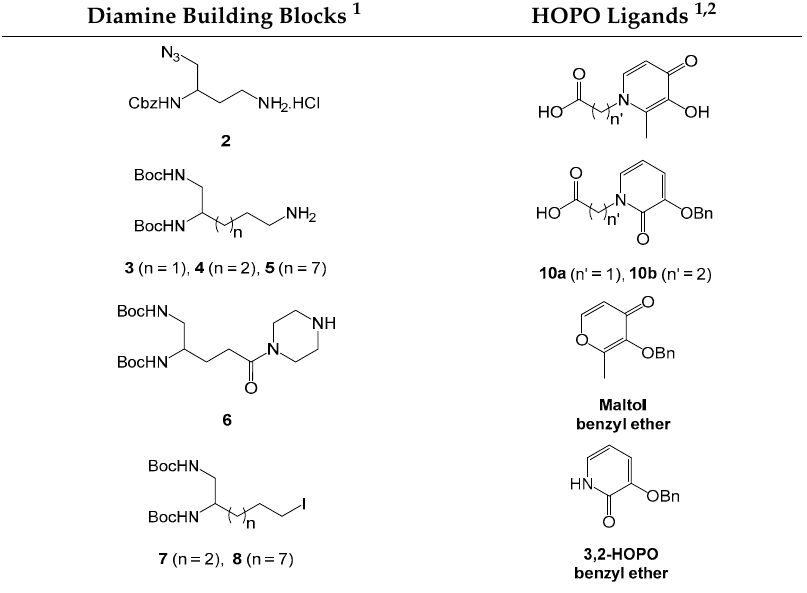
Table 1. Diamine building blocks and HOPO ligands (or other related precursors) implicated in the key coupling step of our AGE / ALE inhibitor synthetic strategy.